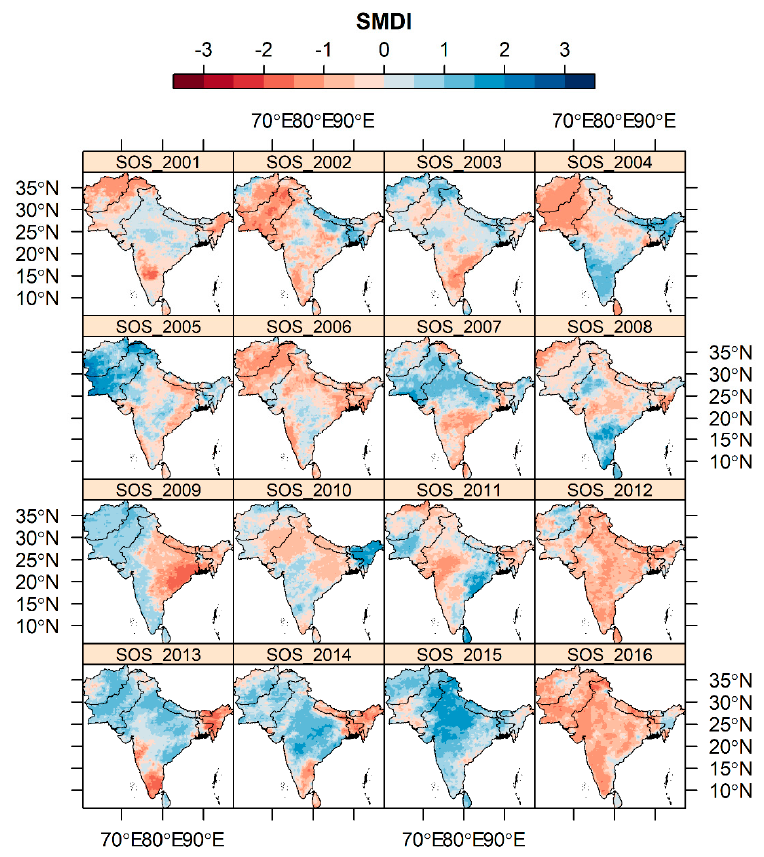
Figure 9. The spatial pattern of SMDI over South Asia during SOS phenology stage from 2001– 2016.